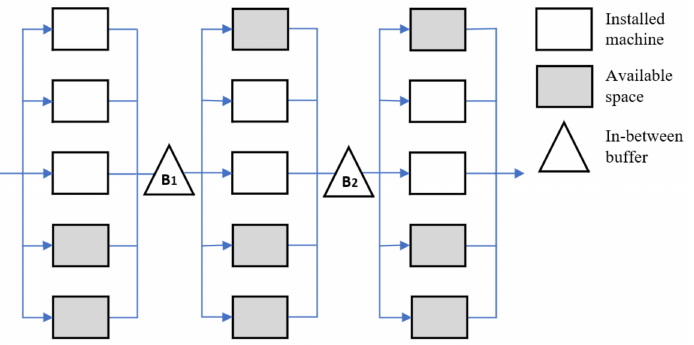
Figure 4. MPFL layout.